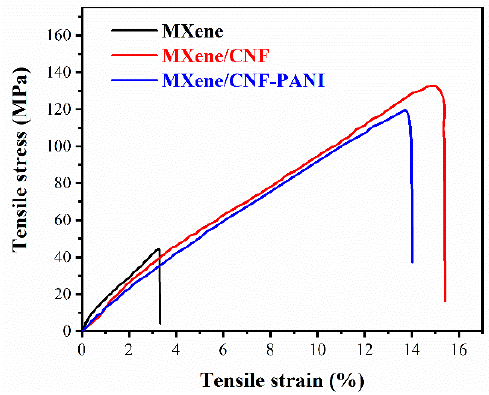
Figure 4. Tensile stress–strain curves of MXene, MXene/CNF aerogel films and MXene/CNF–PANI aerogel films.